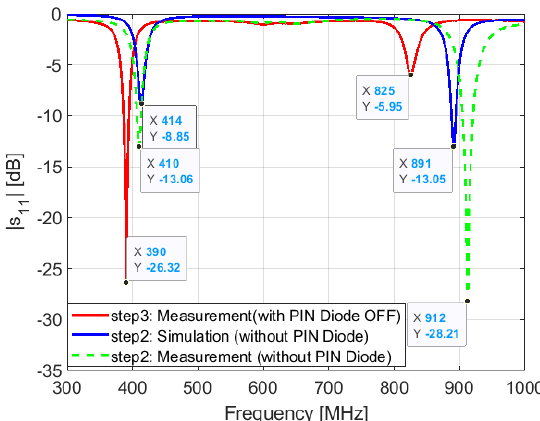
Figure 16. Simulated and measured S11: step 3.